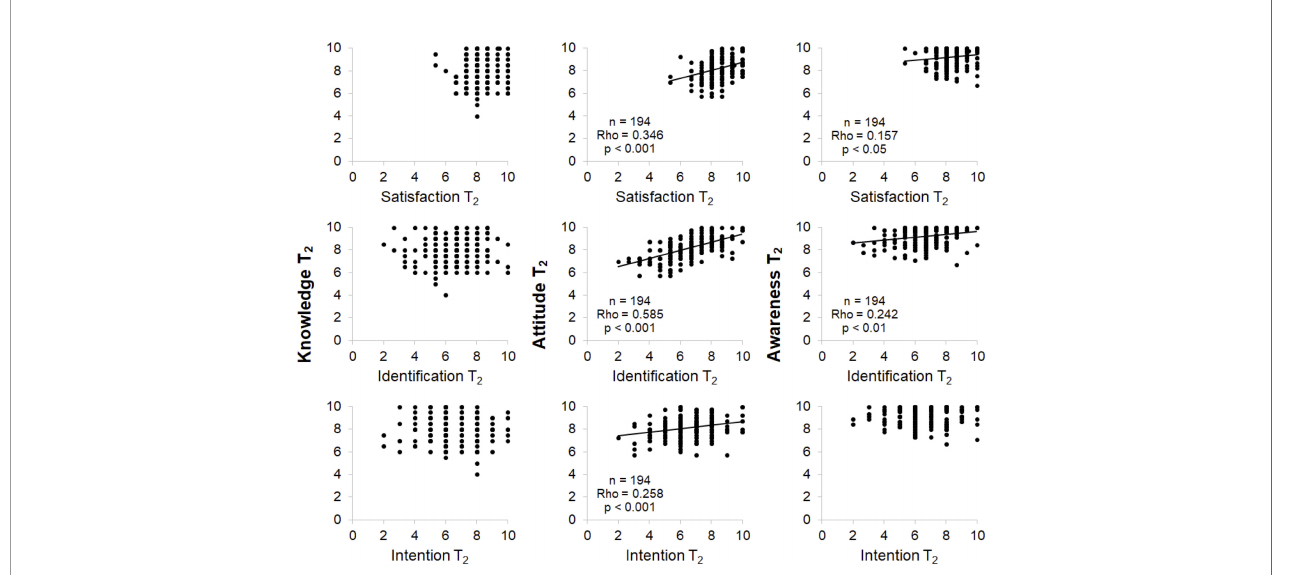
FIGURE 4 | Correlation plots between sustainability variables (knowledge, attitude, awareness) and psychological variables (satisfaction, identi fi cation, intention) at T